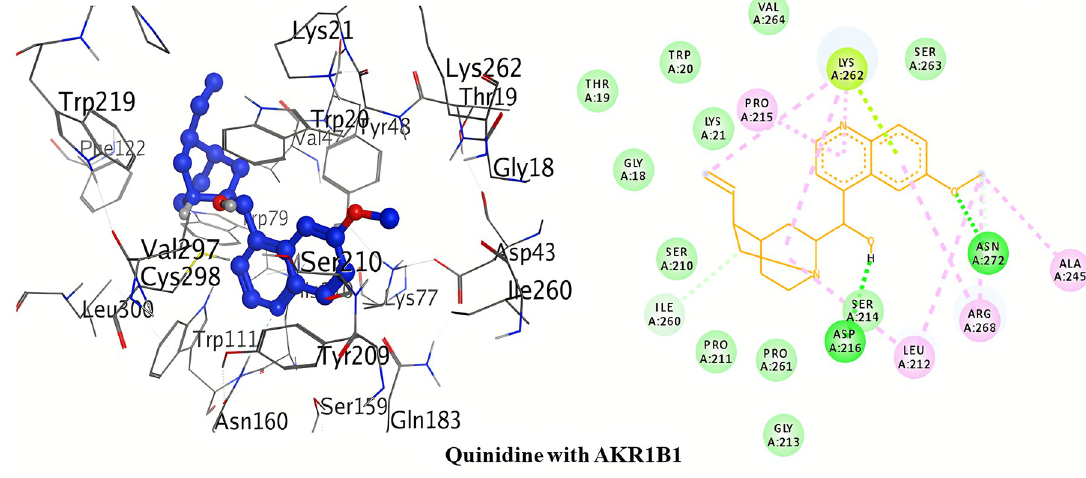
Fig 5. 3D and 2D interactions of quinidine with active site of AKR1B1.